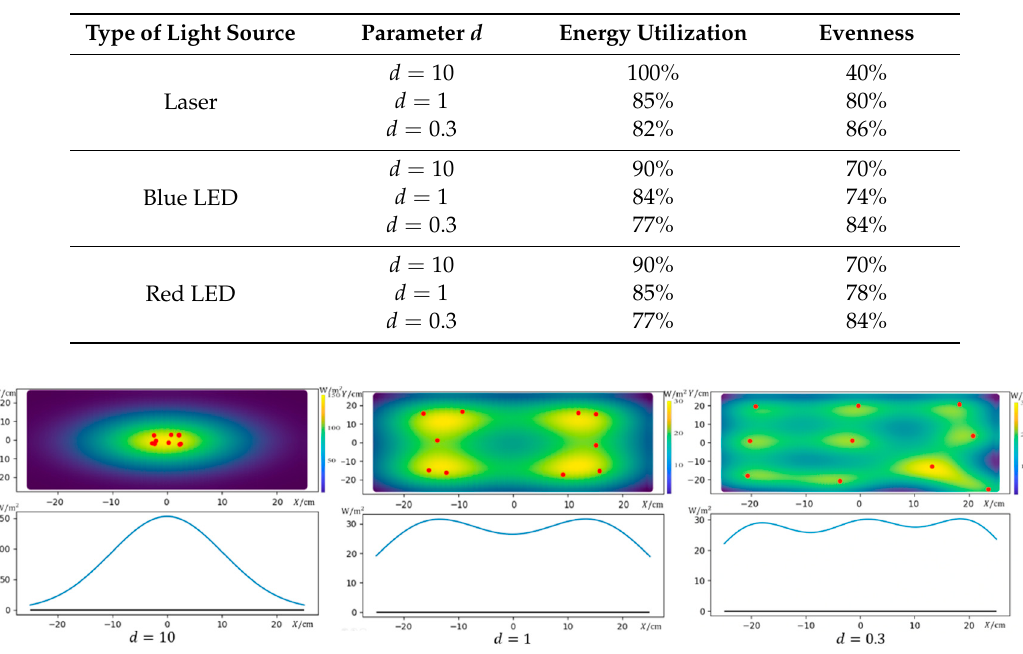
Figure 6. Laser simulation diagram. Appl. Sci. 2020 , 10 , x FOR PEER REVIEW